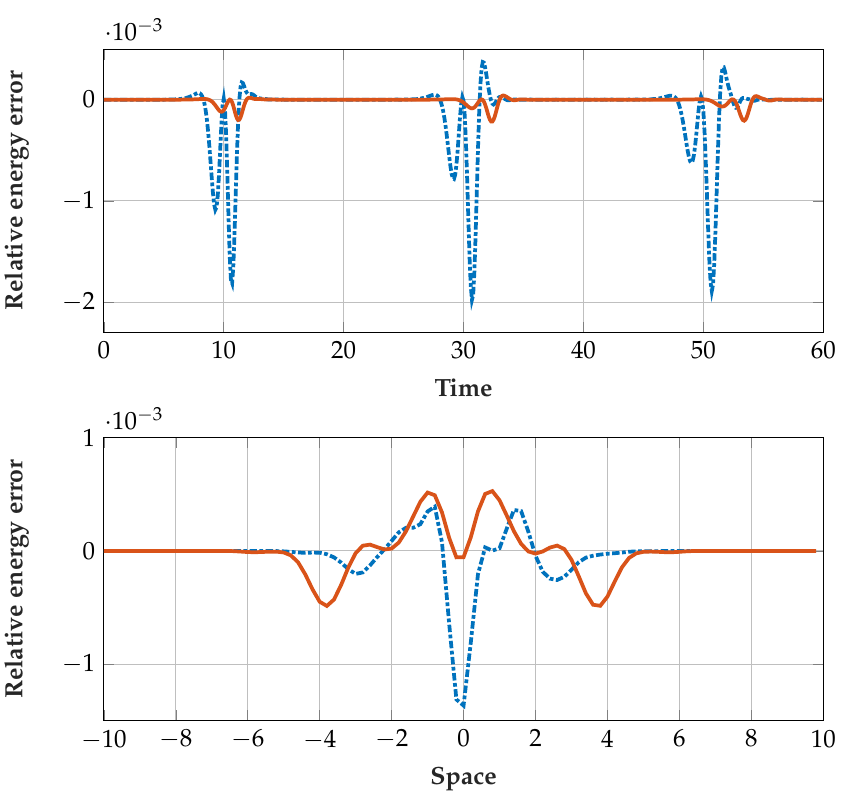
Figure 3. Evolution of the discrete energy error for the linear wave equation using the standard multisymplectic scheme of [11] (blue) versus the proposed one (red). Top: temporal evolution of the discrete energy error (20). Bottom: spatial evolution of the discrete energy error